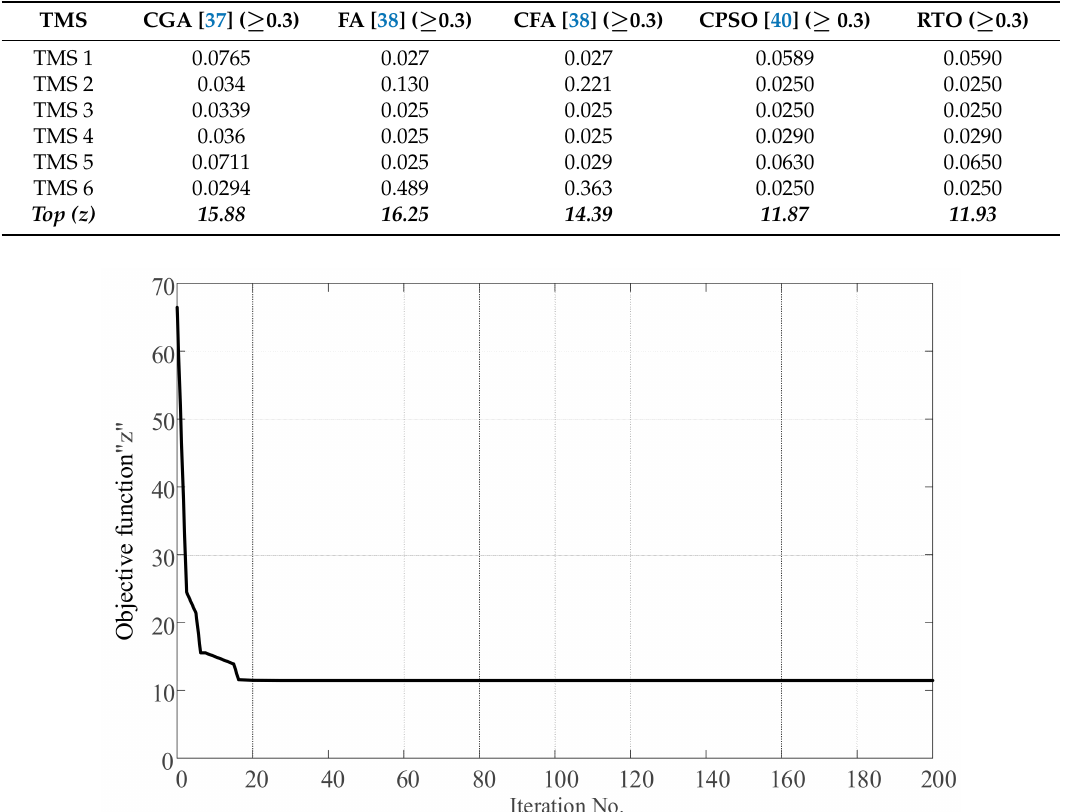
Figure 9. Convergence characteristic representation for Case 2.